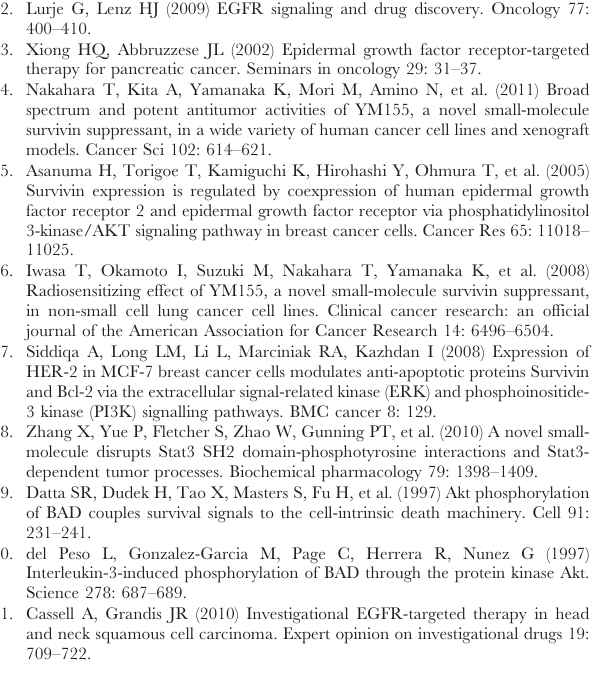
Figure S3 Survivin–XIAP interactions are affected by YM155. Following treatment of PANC-1 cells with 100 nM YM155 for 6 hours, cell lysates were immunoprecipitated with an anti-survivin antibody and immunoprecipitates were probed for XIAP and survivin by Western blotting. The levels of survivin and XIAP in YM155-treated PANC-1 cell lysates are shown. The ratio of XIAP:survivin expression compared to control (0 nM YM155) is shown for each lane (using Multi-Gauge v2.3 software). NC, negative control (no lysates). (TIF) Figure S4 YM155 decreases the expression of PI3K family members and p-Akt levels in pancreatic cancer cell lines. Western blotting was performed after treatment of three pancreatic cancer cell lines with different concentrations of YM155 for 24 hours. (TIF) Figure S5 YM155 downregulates expression of EGFR in various cancer cell lines. A, Full-length blots showing concentration-dependent effects of YM155 on EGFR expression in MIAPaCa-2 are presented. B. YM155 diminished the expression of EGFR in a concentration-dependent manner in HCT116 and KATOIII cells, but not in MKN45 cells. In PC3 prostate cancer cells (C) and H460 lung cancer cells (D), YM155 decreased the expression of EGFR in a concentration-dependent manner, but did not change the expression of XIAP as in previous reports [9,16]. (TIF) Figure S6 YM155 decreases survivin transcriptional activity in PANC-1 cells. A, The viability of PANC-1 cells was examined after transfection with siSurvivin, siEGFR, or scrambled siRNA (40 nM) for 48 hours followed by incubation without or with YM155 (10 nM) for 24 hours. B, YM155 induces a concentration-dependent decrease in survivin transcriptional activity in PANC-1 cells, measured using a survivin gene promoter-driven luciferase reporter.